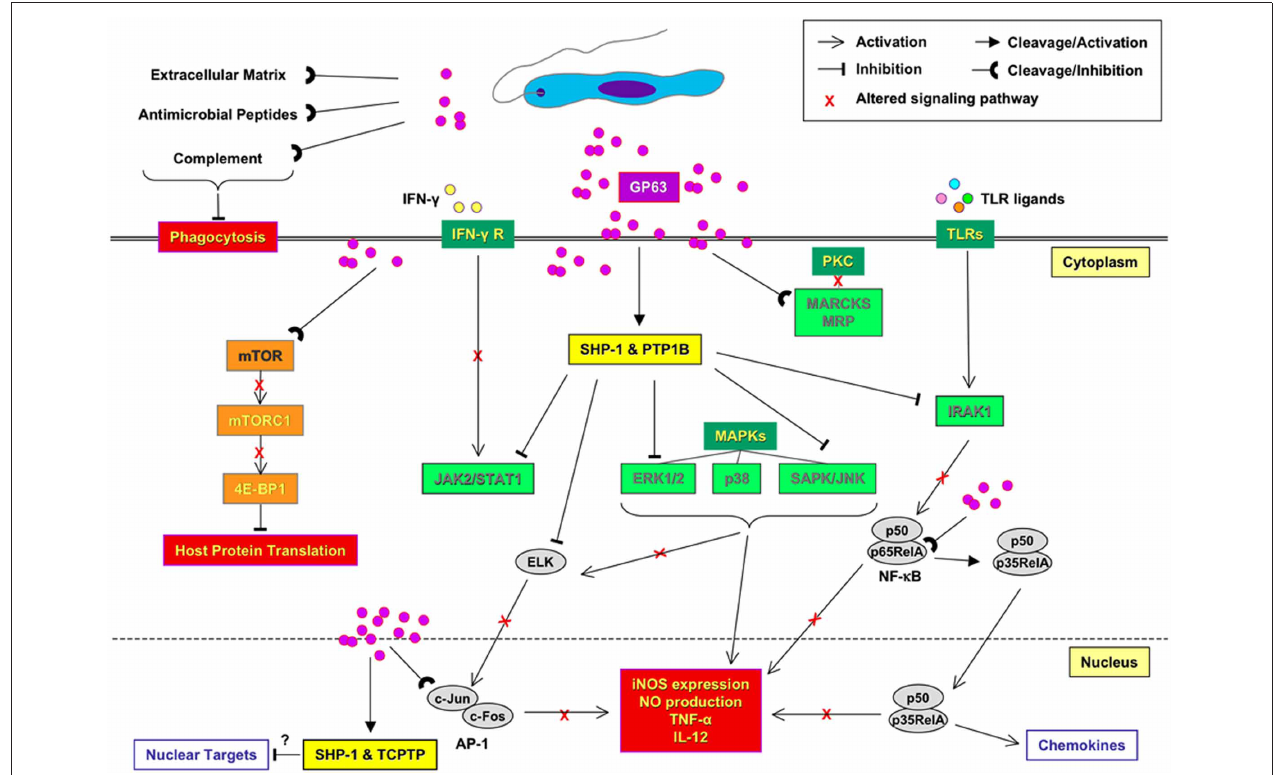
FIGURE 1 | Impact of Leishmania GP63 on macrophage signaling and innate immune response. Before parasite entries into the host macrophage, GP63 provides parasite resistance to the complement-mediatedlysis and facilitate promastigote engulfment by macrophages. Within the host macrophage, GP63 is responsible for the activation of protein tyrosine phosphatases (PTPs; SHP-1, PTP1B, and TCPTP) that lead to the alteration of